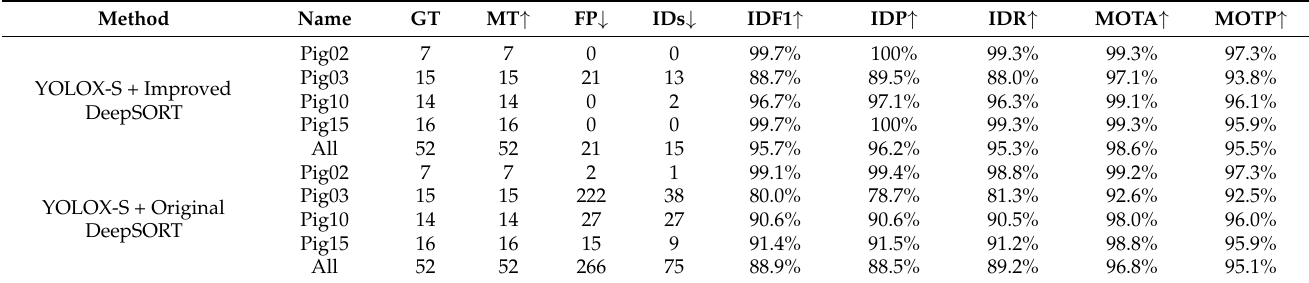
Table 3. Tracking results of improved and original DeepSORT based on YOLOX-S.